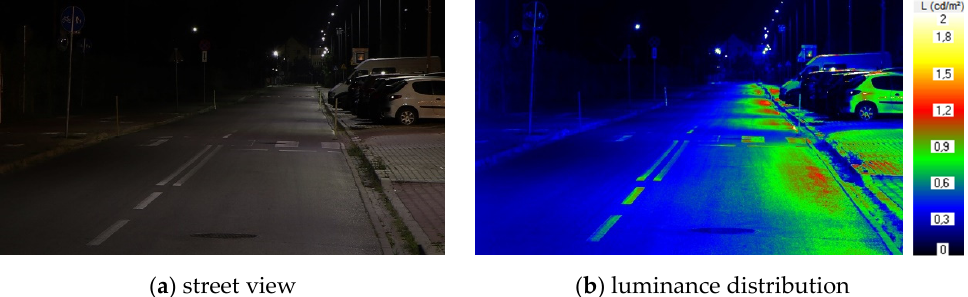
Figure 19. View of the street with lighting when the luminous flux Φ of the lamps is controlled to 67% (average luminance of the roadway is Lav = 0.50 cd/m 2 ).